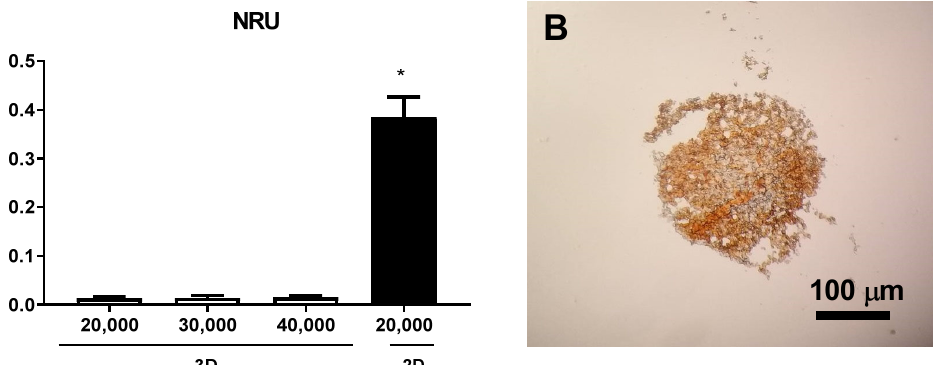
Figure 7. ( A ) NRU assay performed with spheroids of three densities (20,000, 30,000 and 40,000 cells); Bars represent the mean ± SD (n = 5) optical density at 540 nm after 25 min reaction. The Black bar indicates the results obtained with monolaminar cell culture of MC3T3-E1 cells form the same origin as those used in the aggregates. ( B ) Histological section (7 µ m) of a spheroid after the extraction step, showing the remaining dye inside cell aggregate. An asterisk indicates significative difference from other groups ( p < 0.05). All experiments were performed with spheroids at the 4th day after formation.